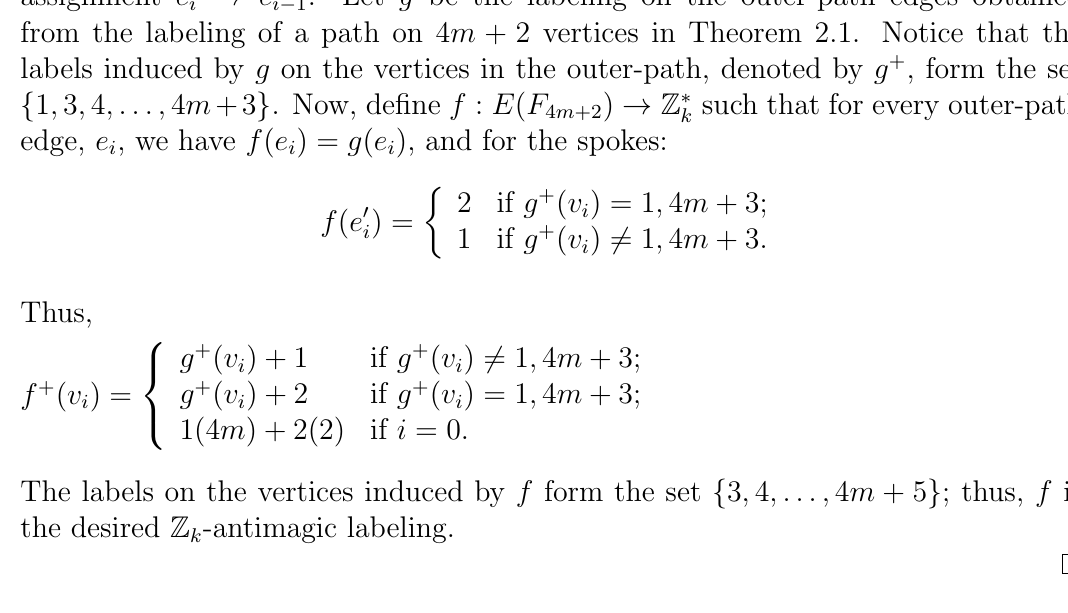
for k (cid:21) 9, 8